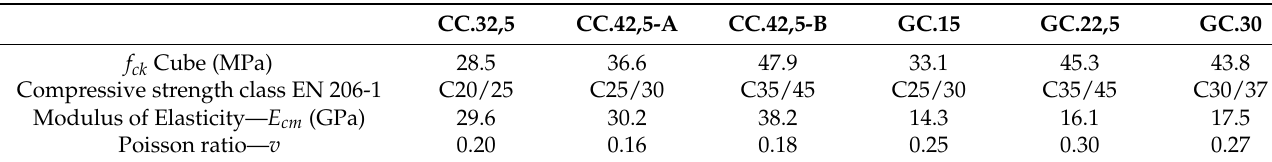
Table 4. Classification of concretes (EN 206-1) with respect to their compressive strength at 28 days (CC) and 7 days (GC). Experimental modulus of elasticity ( E cm ) and Poisson ratio ( v ) of concretes.